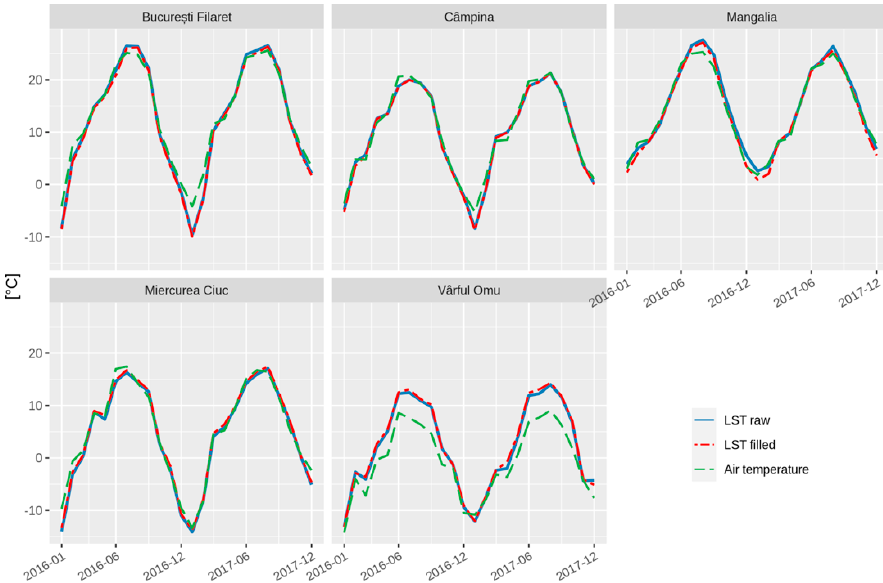
Figure 7. Time series plots of monthly averages LST data (raw and filled) and air temperature extracted at five weather stations location from 2016 to 2017.